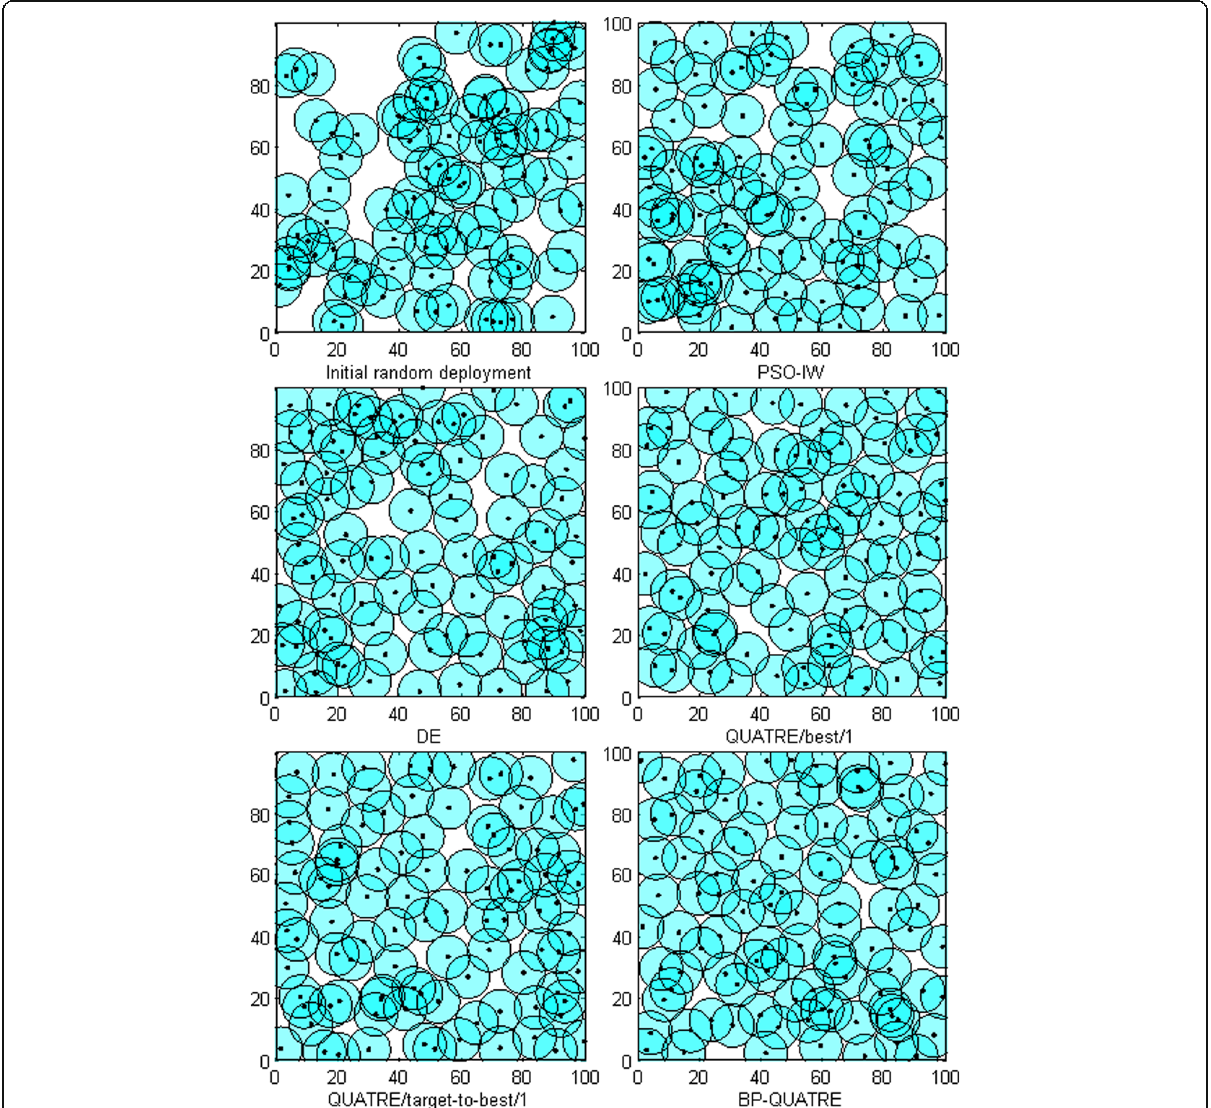
Fig. 3 Initial random deployment and final sensor positions based on each algorithm. The figure presents Initial random deployment and the final deployment of 100 sensor nodes in the monitored target area based on each competing algorithm (i.e., PSO-IW, DE, QUATRE/best/1, QUATRE/target-to-best/1, and BP-QUATRE). The black dots represent the final positions of the sensor nodes, and the circles represent the relative monitoring areas of the sensor nodes. The coverage rates obtained by PSO-IW, DE, QUATRE/best/1, QUATRE/target-to-best/1, and BP-QUATRE are 88.73%, 91.83%, 93.67%, 93.05%, and 93.89%,